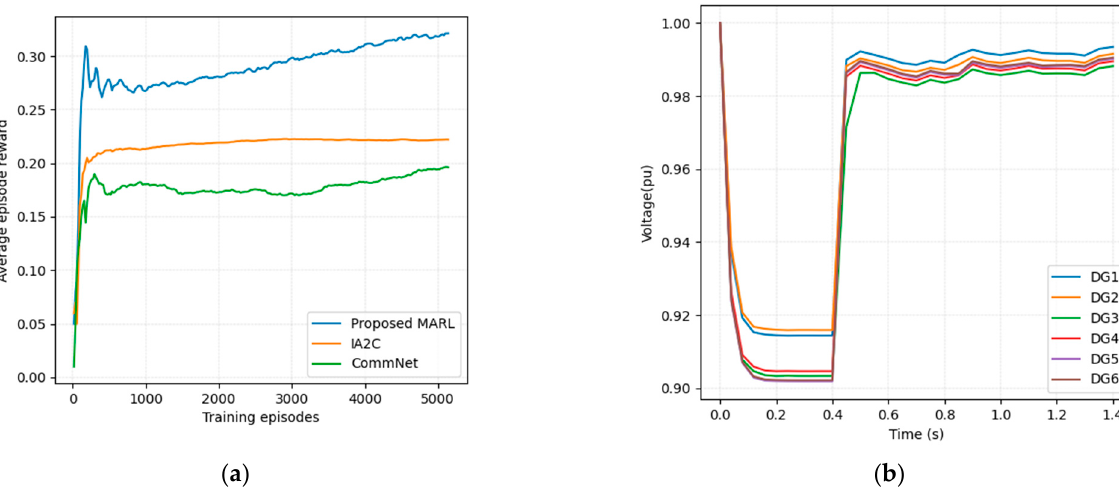
Figure 5. Performance trained MARL policy under 25% load disturbance: ( a ) MARL training curves for IEEE 34-bus feeder system. The lines show the average reward per training episode, which is smoothed over the past 100 episodes; ( b ) performance of voltage control.